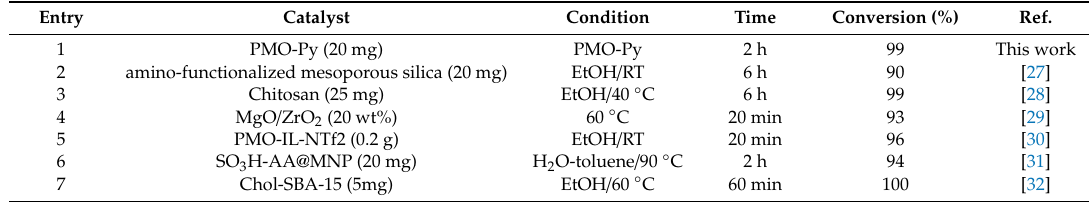
Table 2. Comparison of the catalytic efficiency of PMO-Py in the reaction of benzaldehyde, malononirile and the previous literature.